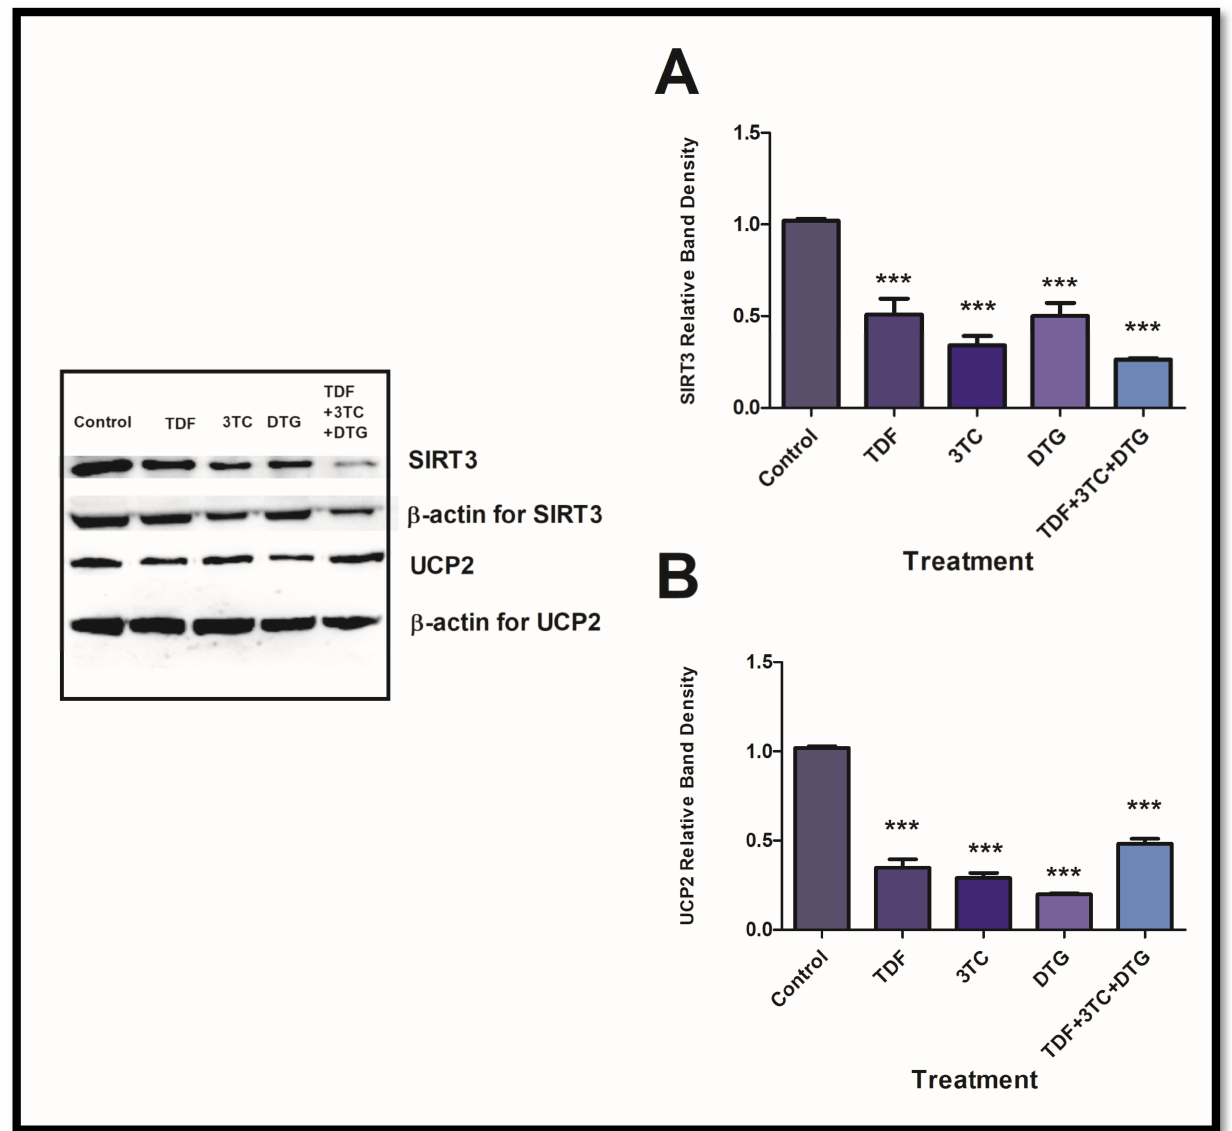
Figure 3. ARVs suppressed mitochondrial stress responses. SIRT3 protein expression ( A ) was significantly decreased with corresponding decreases in UCP2 protein expression ( B ). *** p < 0.0001 relative to control (Raw blot images are available in Supplementary Materials: Figures